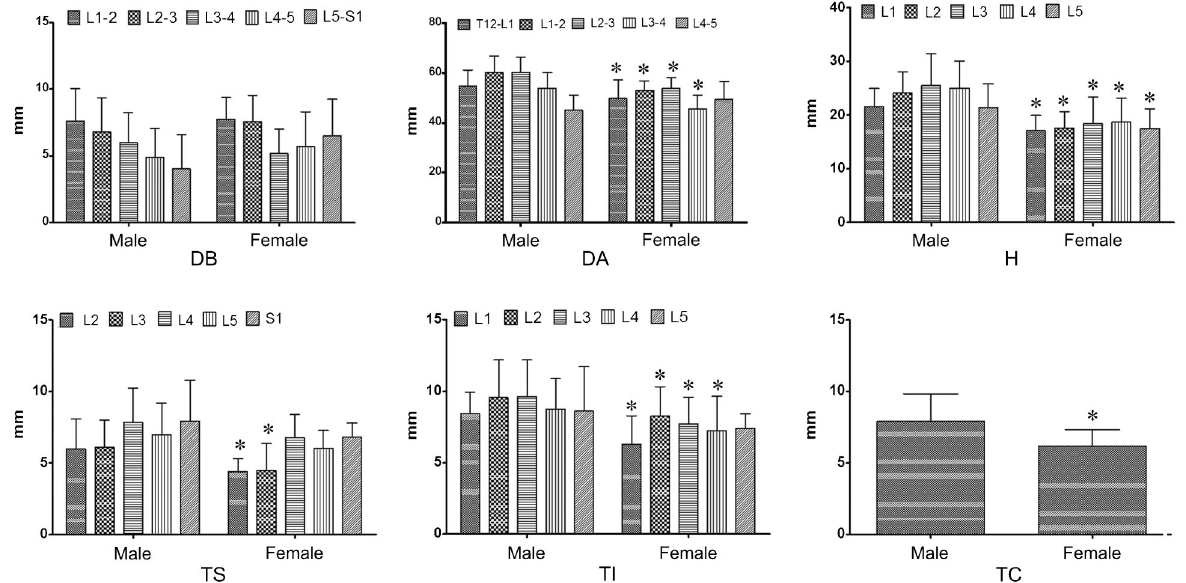
Figure 2. Comparison of each parameter (DB, DA, H, TS, TI, and TC) between males and females. DB: distance between two adjacent spinous processes; DA: distance across two adjacent spinous processes; H: height of the spinous processes; TS: thickness of the superior margin of the spinous processes; TI: thickness of the inferior margin of the spinous processes; TC: thickness of the central spinous processes. *P , 0.05 female vs male (one-way ANOVA).